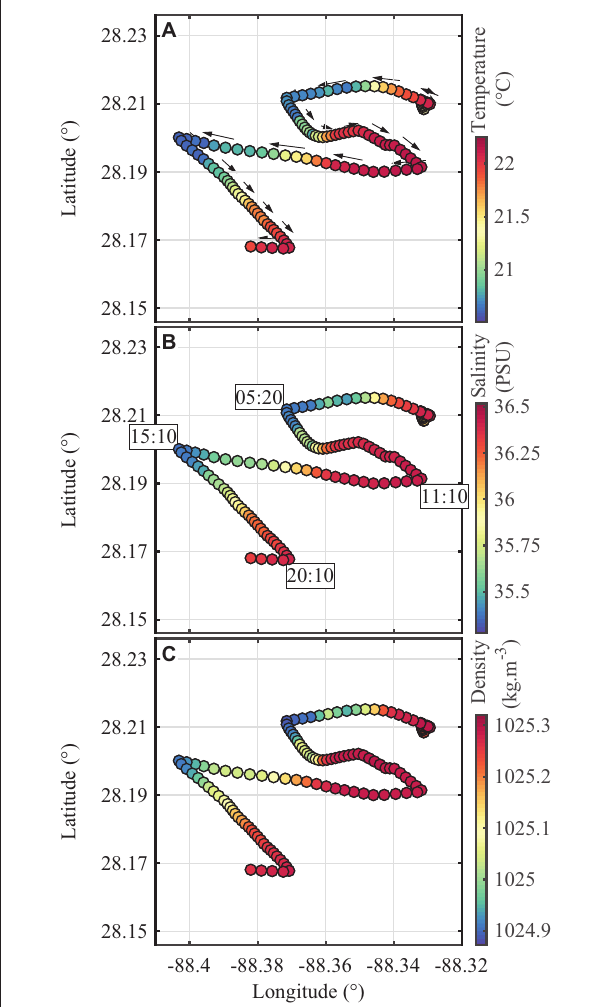
FIGURE 13 | Water properties measured by the GPCTD mounted on the sub of the SV2 Wave Glider Pascal while sampling a submesoscale frontal structure for 21 h during the LASER2016 experiment starting at 1800 UTC 30 January 2016. (A) Temperature. (B) Salinity. (C) Density. Measurements were performed at a depth of 6.38 m. The black arrows in the top panel indicate the course of the Wave Glider, while boxed numbers in the middle panel correspond to the elapsed time in hour:minute since the beginning of the sampling period. On the east side of the front, waters from the central area of the Gulf of Mexico were warmer, saltier and heavier than the cold, fresh, and light waters discharged from the mouth of the Mississippi River on the west side of the